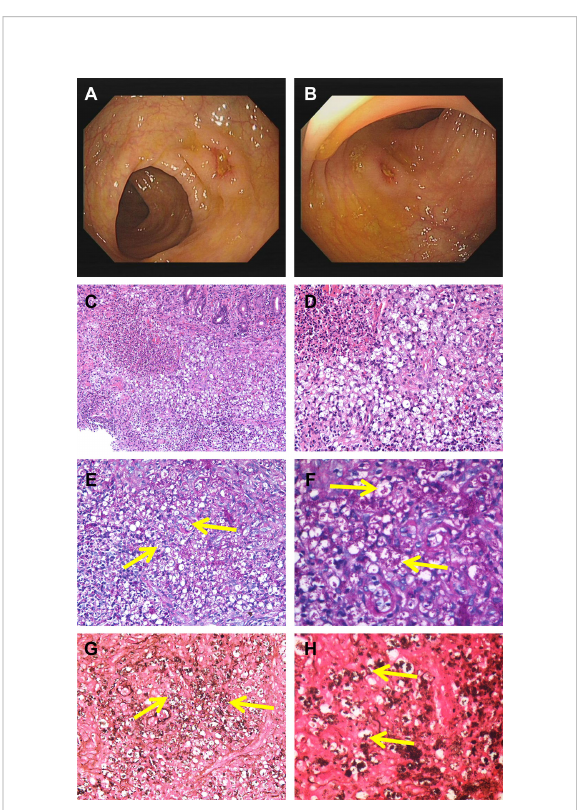
FIGURE 1 Colonoscopy revealed scattered ulcers with unknown etiology located at transverse colon (A) and the ascending colon (B) . H&E staining showed in fi ltration of clustered microorganisms and granulomas in the lamina propria at ×200 (C) and ×400 (D) . PAS staining revealed some intracellular and extracellular yeasts (yellow arrow) distributed in the colon at ×400 (E) and higher magni fi cation (F) . GMS staining showed abundantly septate yeast-like microorganisms (yellow arrow) at ×400 (G) and higher magni fi cation (H) . PAS, periodic acid-Schiff; GMS, Gomorrah ’ s methylamine